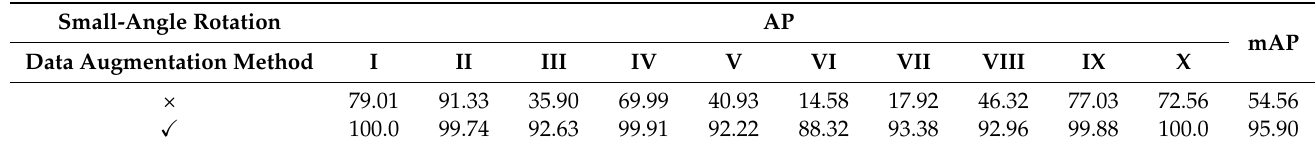
Figure 25. Recognition results for different rotation angles of Map I: ( a ) original image, ( b ) rotated by 2.5°, and ( c ) rotated by 5°. Table 7. Comparison of the results based on whether the small-angle rotation data-augmentation method was used during training, which was tested on our test set rotated by